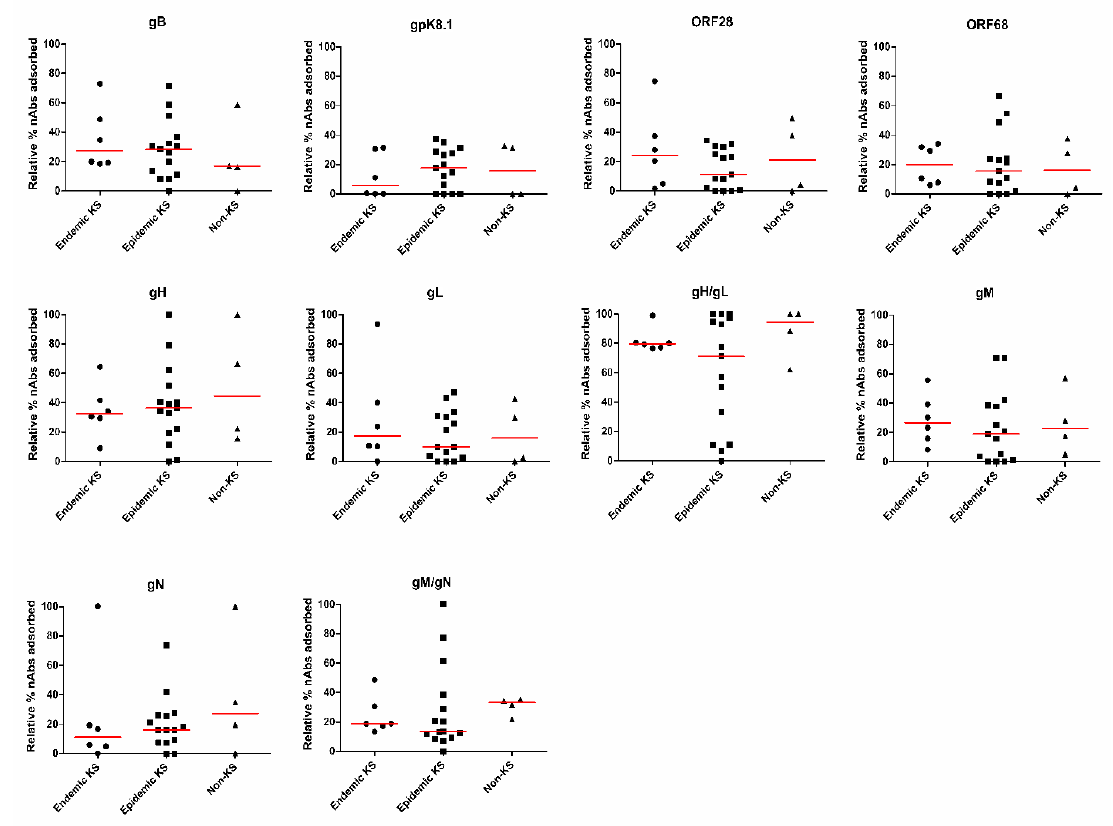
Figure 5. Comparison of nAbs responses to each KSHV glycoprotein in the EnKS, EpKS and non-KS groups. The nAbs responses against each KSHV glycoproteins were compared between the EnKS, EpKS and non-KS individuals using the Mann–Whitney test.